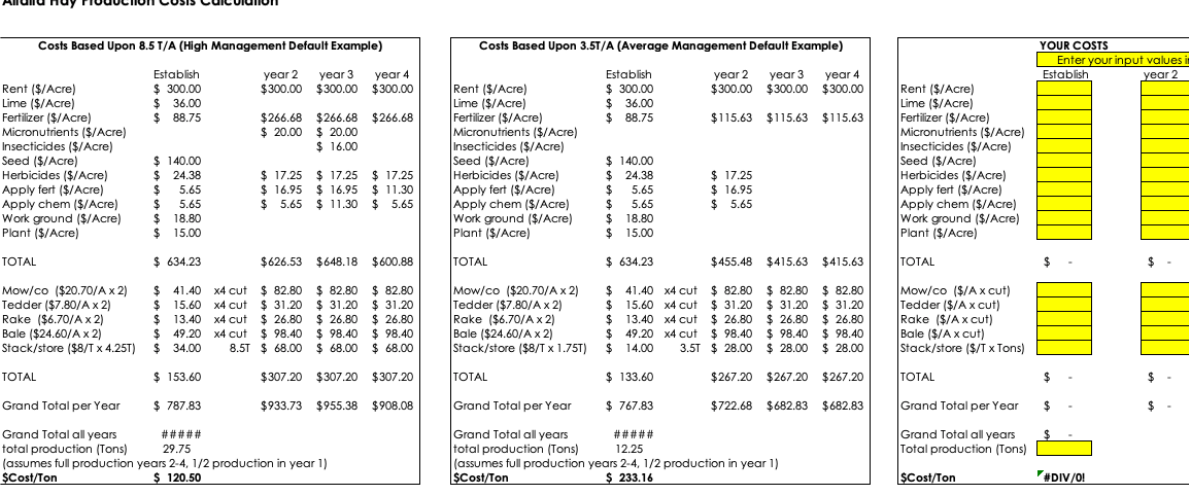
Figure 14. Decision support tool for grass and alfalfa production developed by Natural Resource Conservation Service (NRCS). Yellow cells are input